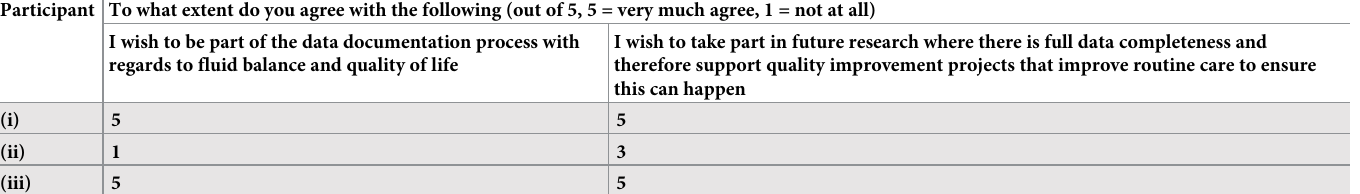
Table 3. Participant views on PROMs. Participants were asked to what extent they agreed with specific statements on how patient reported outcome measures (PROMs) may be used (1 = not at all, 5 = very much agree). Participant To what extent do you agree with the following (out of 5, 5 = very much agree, 1 = not at all) I wish to be part of the data documentation process with regards to fluid balance and quality of life